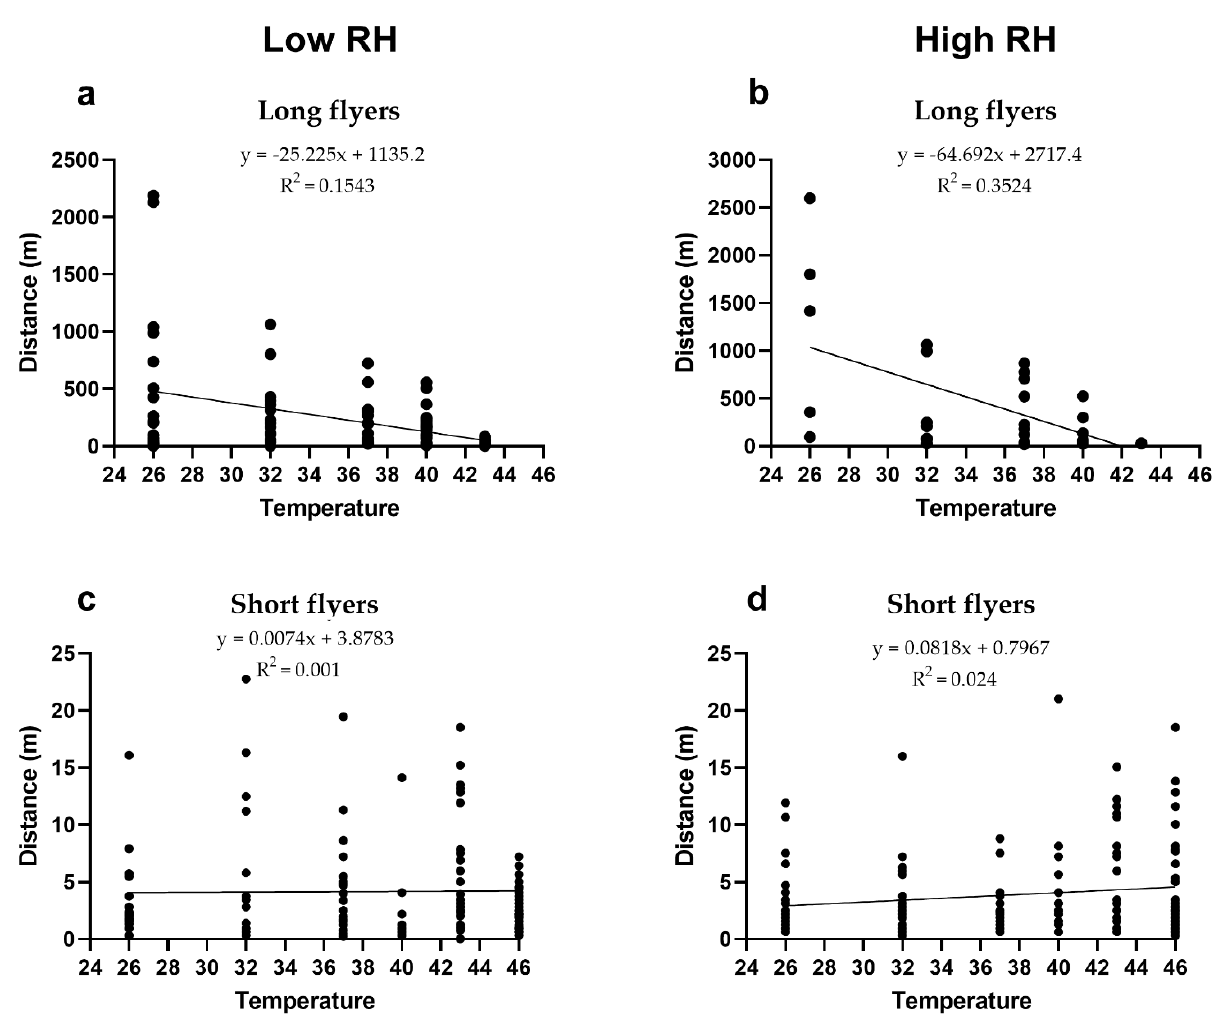
Figure 2. Linear regression showing the effect of temperature (°C) on distance flown by D. citri for: ( a ) long flyers at low RH, ( b ) long flyers at high RH, ( c ) short flyers at low RH, and ( d ) short flyers at high RH.